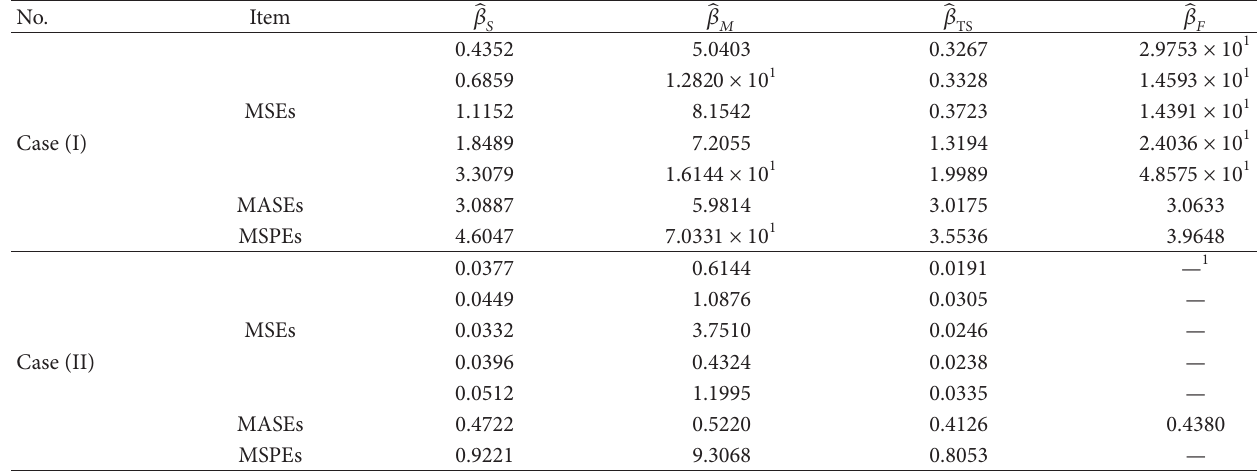
adjusted model and the full